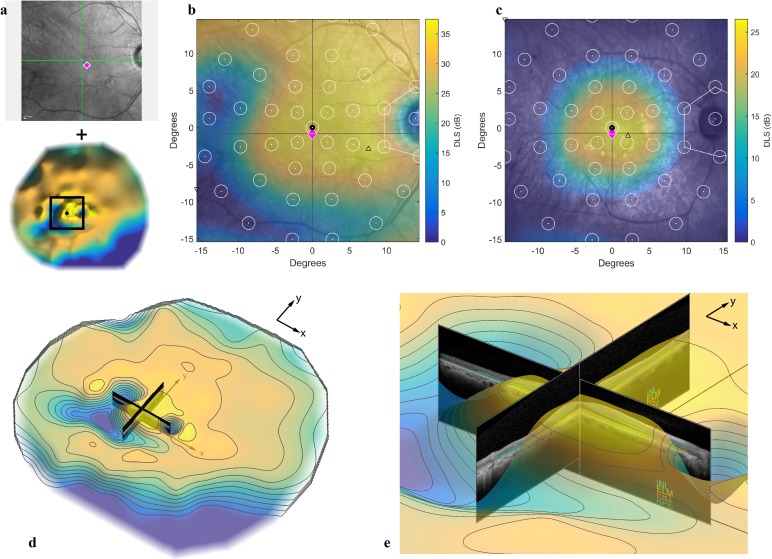
Registration of anatomic and functional data.(a) The IR fundus image (top) and the HOV sensitivity surface (bottom) were first registered automatically by aligning the fovea (magenta diamond) with the center visual field point (black circle). The diamond’s x and y coordinates were derived from the H and V b-scans, respectively. The green lines on the IR image indicate the H and V b-scan locations. The black square on the HOV represents the IR image size (30°). The HOV has been reflected to match the fundus orientation. (b) The HOV was then manually shifted until the natural scotoma was aligned with the optic disc. The white dots indicate the locations of SAP test grid, and the radius of each white circle corresponds to a size V stimulus. (c) For HOVs with no natural scotoma, the optic disc was aligned with the expected location of the blind spot (white polygon). (d) Aligned OCT b-scans and HOV with contour lines for the case shown in b. (e) Close-up of central field. A relationship is evident between steep depressions in the HOV surface and the edges of the EZ (the yellow line labeled PR1 on the b-scans).